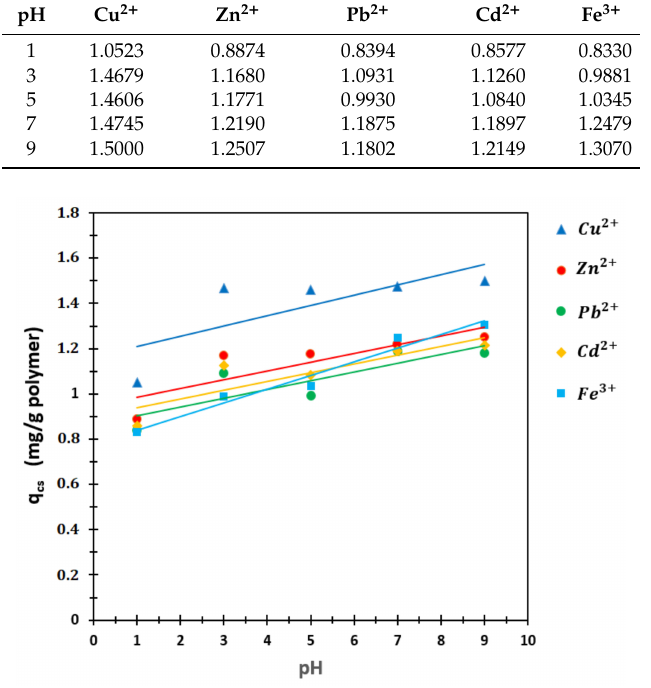
Figure 11. q cs graph against di ff erent pHs on the P (AA / Kry23-DM) SAP.